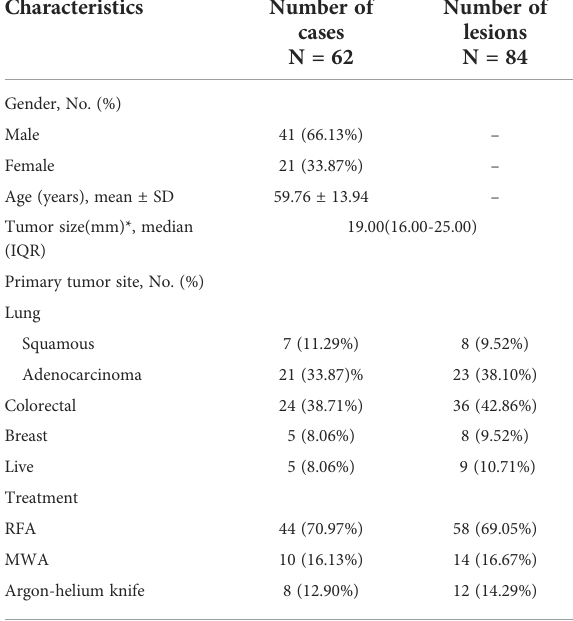
TABLE 1 Baseline characteristics of the study